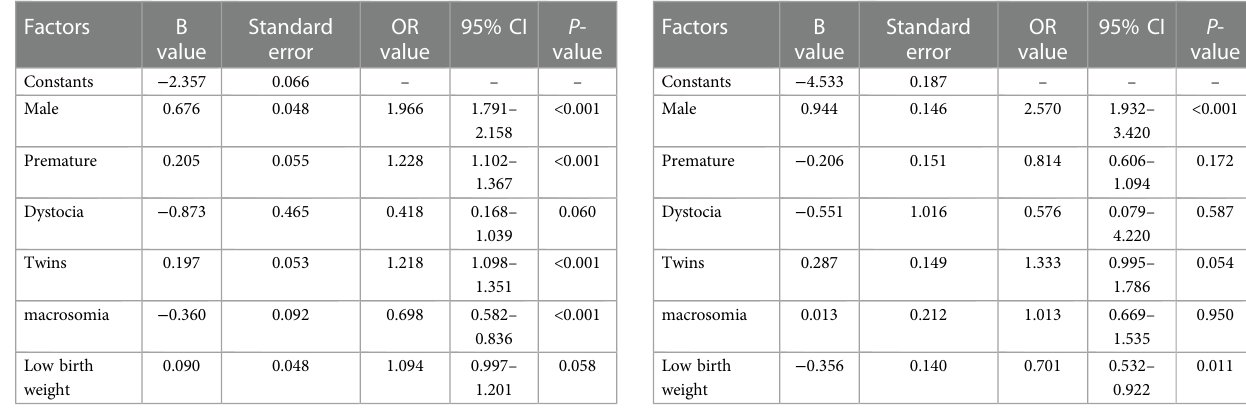
TABLE 4 Multivariate logistic analysis of risk factors for RPD.